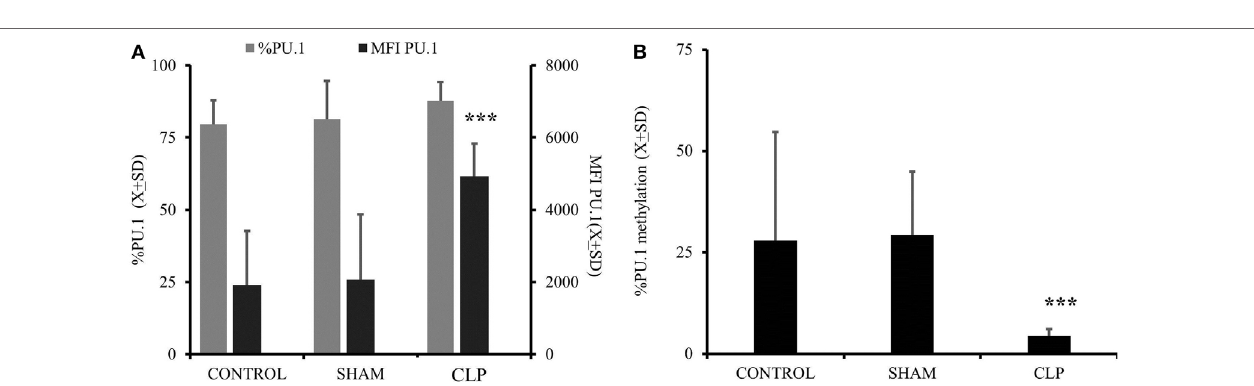
FigUre 3 | activation of macrophage-colony stimulation factor (M-csF) was elevated in animals 28 days after cecal ligation and puncture (clP) due to increased promotor activity and concomitant with demethylation of the promotor . Monocytes (MO) obtained from bone marrow were collected from all three studied groups (CONTR; n = 6, SHAM; n = 6, CLP; n = 8). Dye tagged anti PU.1 antibody was incubated with permeabilized cells for 1 h and subjected for flow cytometry as described before. Expression of the PU.1 was showed as a difference in mean fluorescent intensity as compared to cells incubated with non-specific controlled dye tagged antibody in addition to percentage of positive cells (%) (a) . A 3-kb fragment of the SPI1 gene encoding the PU.1 transcription factor was analyzed to measure the degree of the methylation using the same donors as for PU.1 measurements (B) . Bars represent average of results ( X ) with SD. Data were analyzed by one-way ANOVA for multiple group comparisons with a Bonferroni test for post hoc analysis (* p < 0.05, ** p < 0.01, *** p < 0.001).